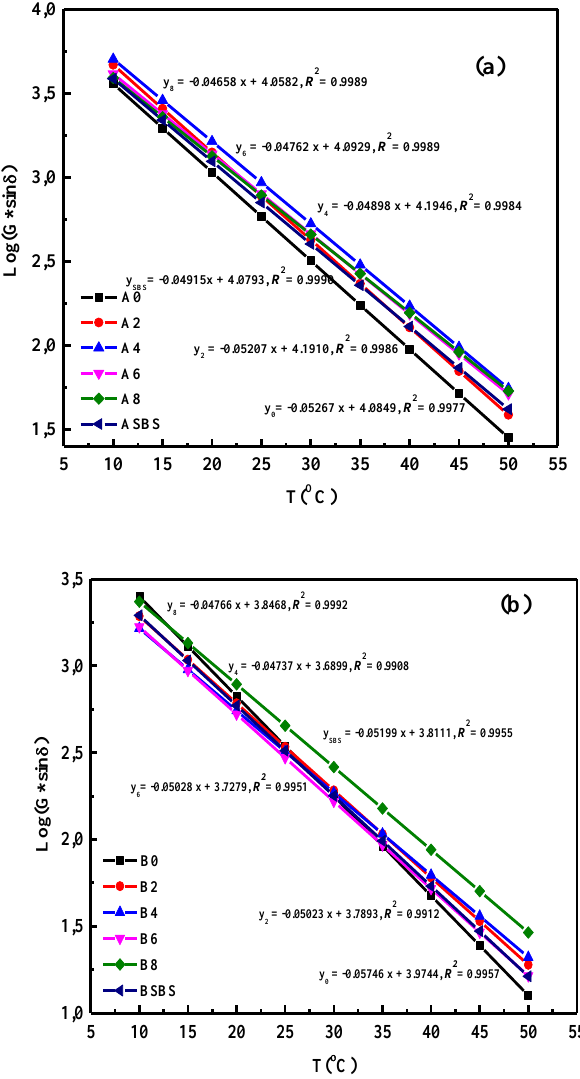
Figure 5. E ff ects of temperature on the fatigue factor of ( a ) the base and ( b ) the SBS latex-modified Figure 5 . Effects of temperature on the fatigue factor of the base and the SBS latex-modified